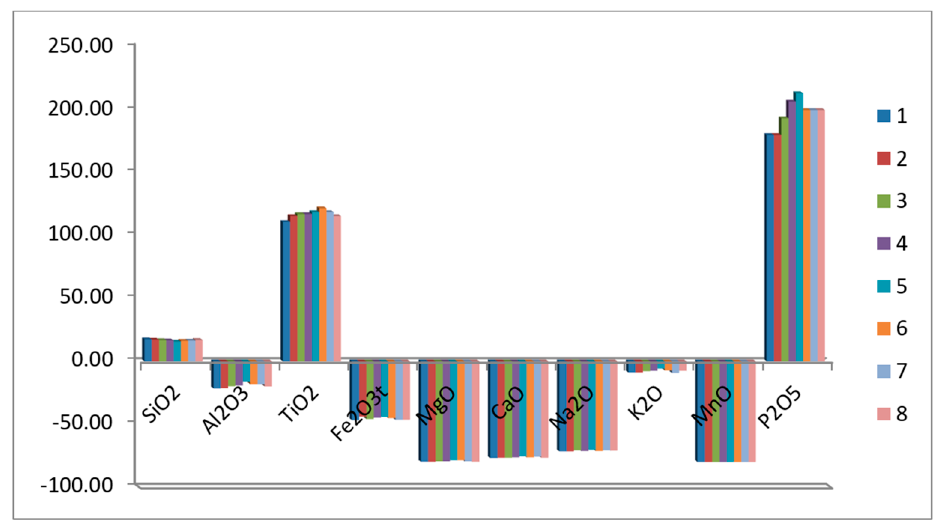
Figure 3. Depletion-enrichment variation diagram of major oxides in the studied altered granites.